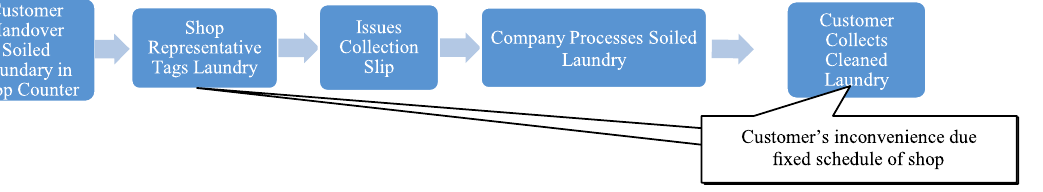
FIG. 3. OVER THE COUNTER COLLECTION / DELIVERY OF LAUNDRY